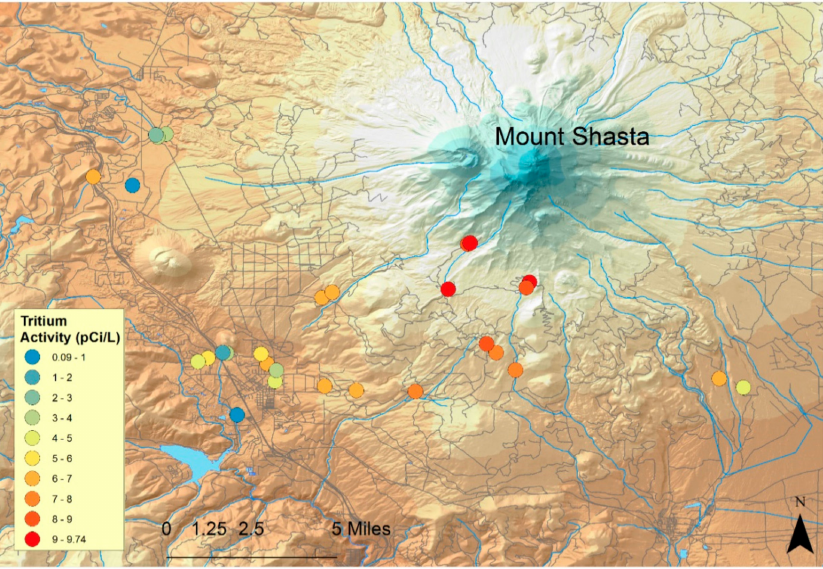
Figure 9. Tritium activity generally decreases with decreasing sample elevation (Table